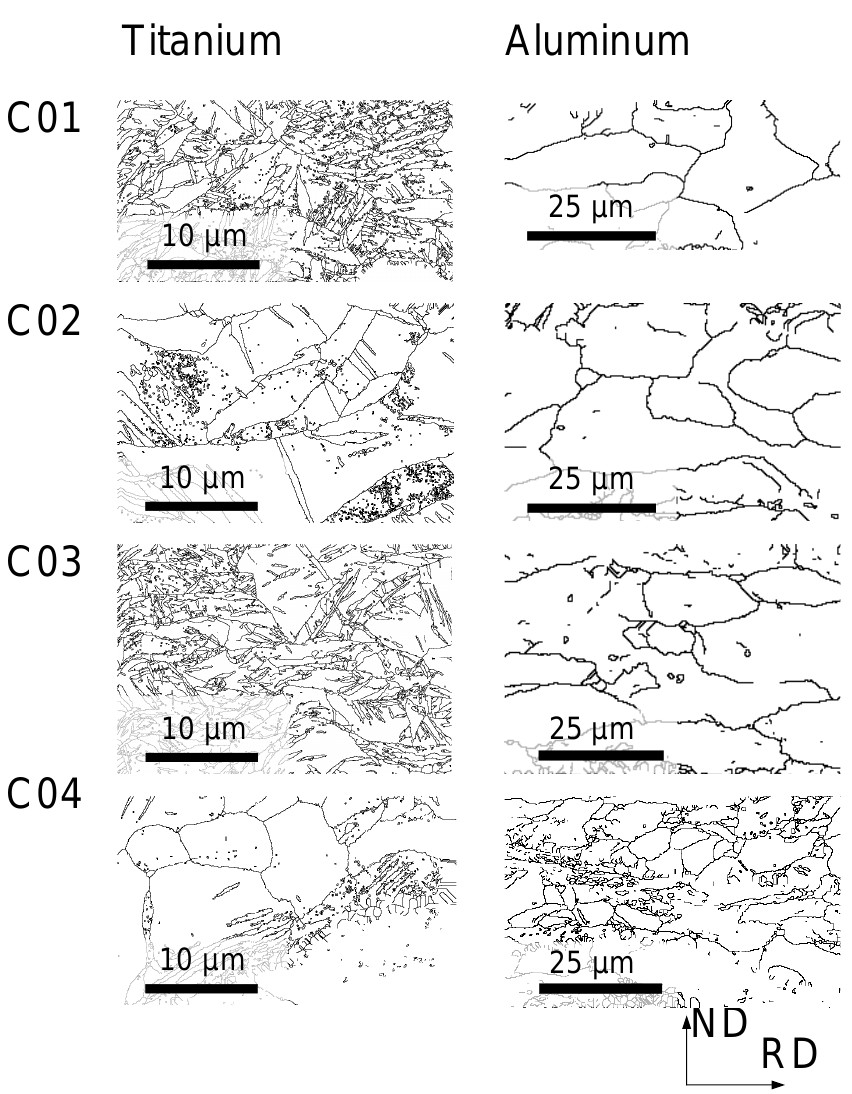
Figure 12. Grain boundary maps ( i.e. , boundaries with a misorientation angle of 15 ◦ and above) of the Ti (left) and Al (right) layers within a 160-layered Ti/Al composite sheet. The sheets are being deformed by rolling with one (C01) and three (C02-04) rolling passes. The speed ratio amounts to 1 (C01 and C02), 1:1 (C03) and 1:5 (C04),